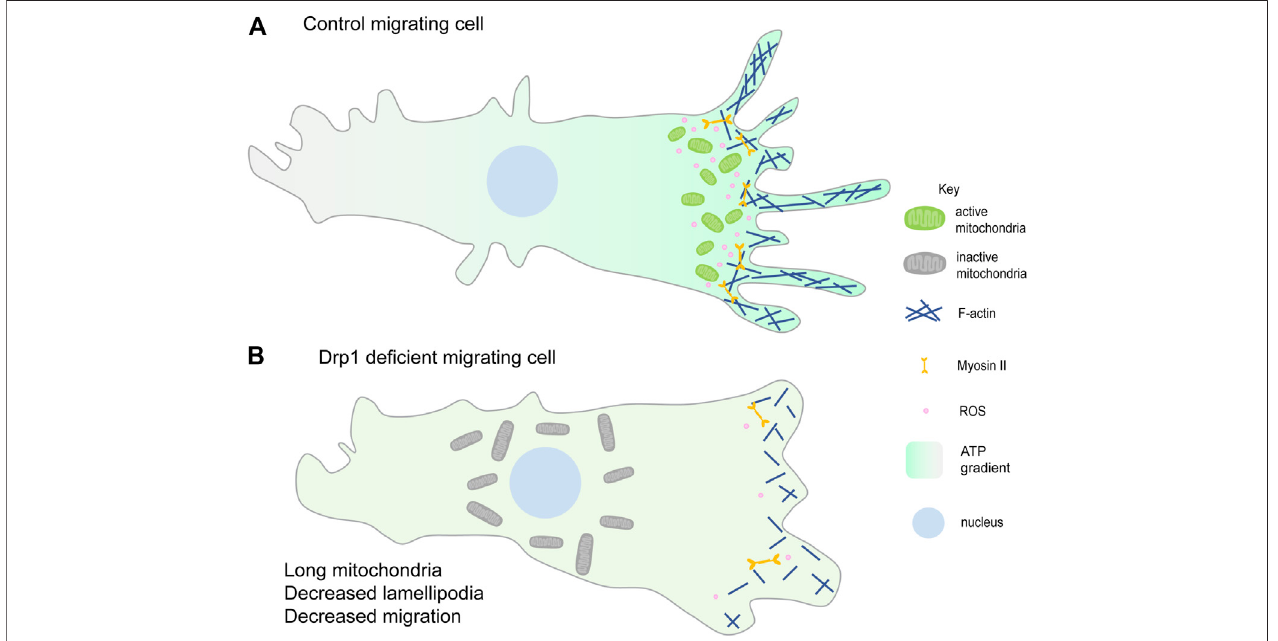
FIGURE3| Mitochondrialfragmentationattheleadingedgeofthemigratingcell. (A) Fragmentedmitochondria(green)migratetowardstheleadingedgeandaidin lamellipodia formation hence promoting migration. Mitochondrial ATP (higher ATP in the migrating cell shown with the green gradient) is essential for lamellipodia formation and hence migration (Zhao et al., 2012; Caino et al., 2016). ROS production (pink) at the leading edge also enhances cell migration (Lee et al., 2018; Ko et al., 2018). (B) Loss of mitochondrial fi ssion or increased fusion prevents mitochondrial relocalisation to the leading edge (shown by the perinuclear gray larger mitochondria) and decreases lamellipodia formation thereby decreasing cell migration. Reduced lamellipodia formation could be due to decreased F-actin polymerisation and reduced ROS at the leading edge. Decreasing ROS also decreases cell migration (Wang et al., 2012; Zhao et al., 2012; Desai et al., 2013).